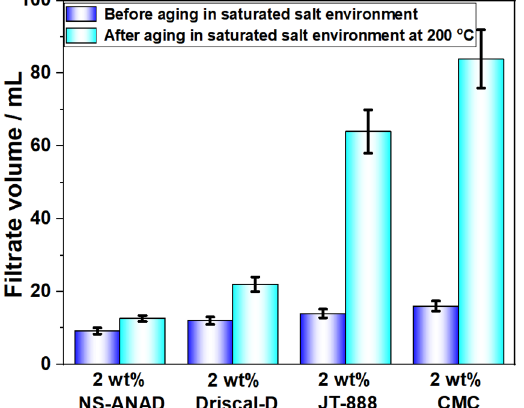
Figure 9. Comparison of NS-ANAD co-polymer and different commercial fluid loss control agents.